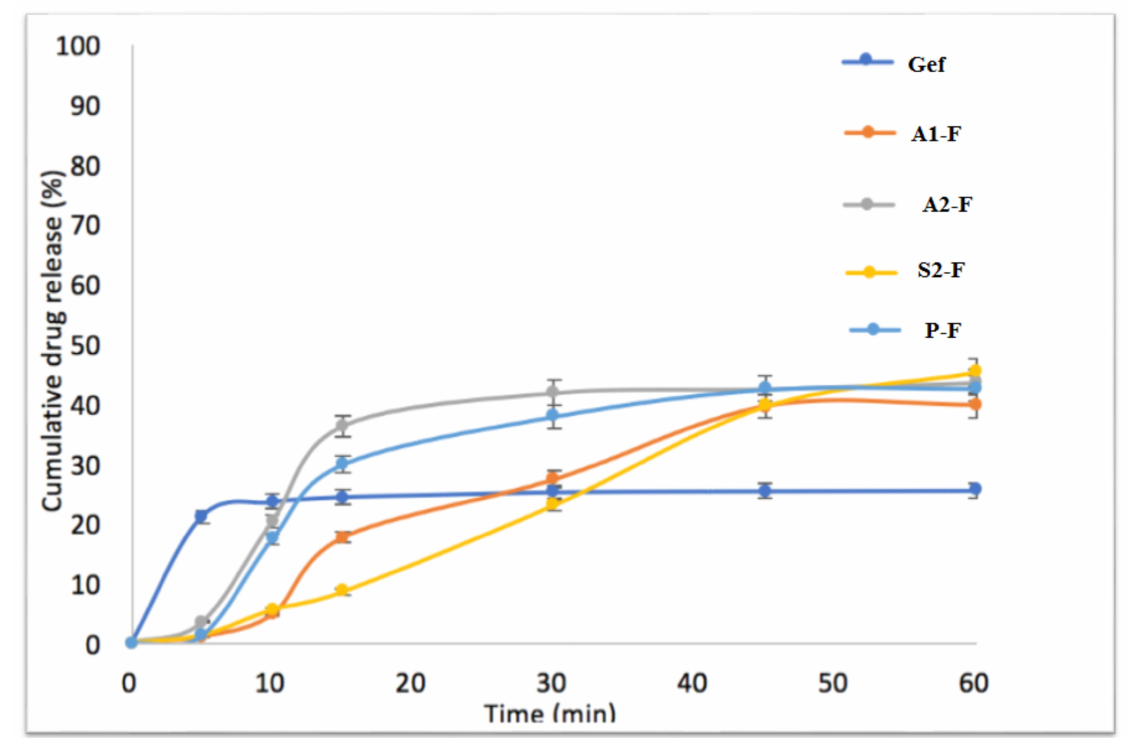
Figure 9. In vitro dissolution profile of Gef from pure Gef and various SDs prepared using fusion method (mean ± SD, n =